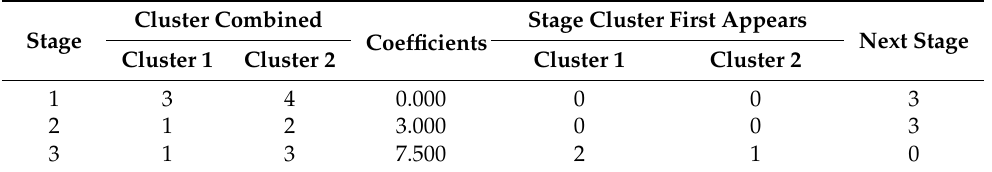
Table 8. Agglomeration schedule of dendrograms showing genetic relationships among Salmonella serovars based on ERIC PCR. The similarity was calculated from the coefficient by the UPGMA.